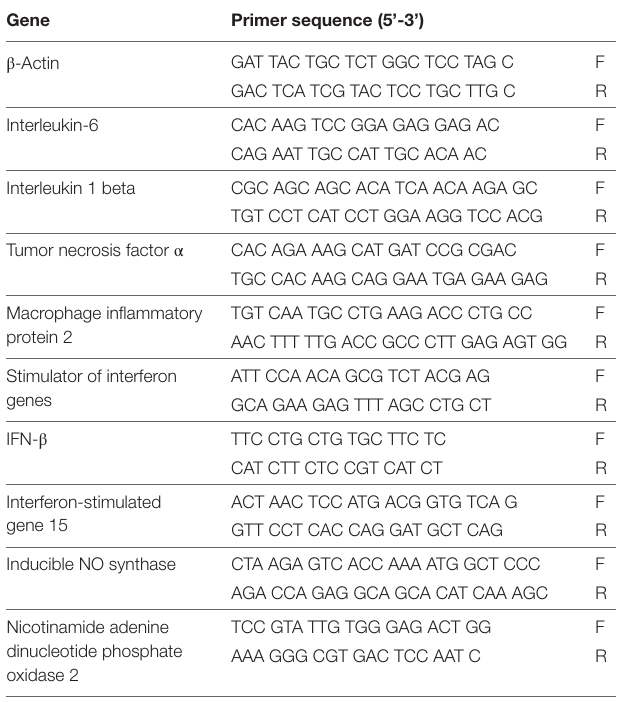
TaBle 1 | Nucleotide sequence of the specific primers used in PCR amplification.